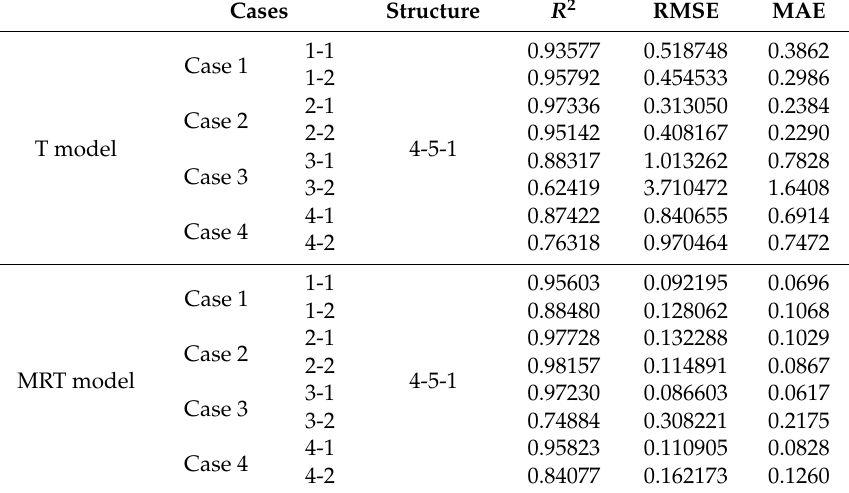
Table 6. Accuracy of T and MRT prediction models according to the data characteristic.